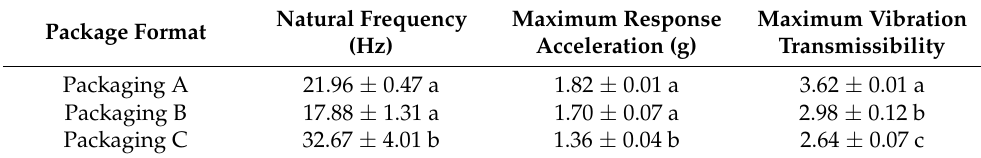
Table 3. Vibration transmission characteristics of three packaging